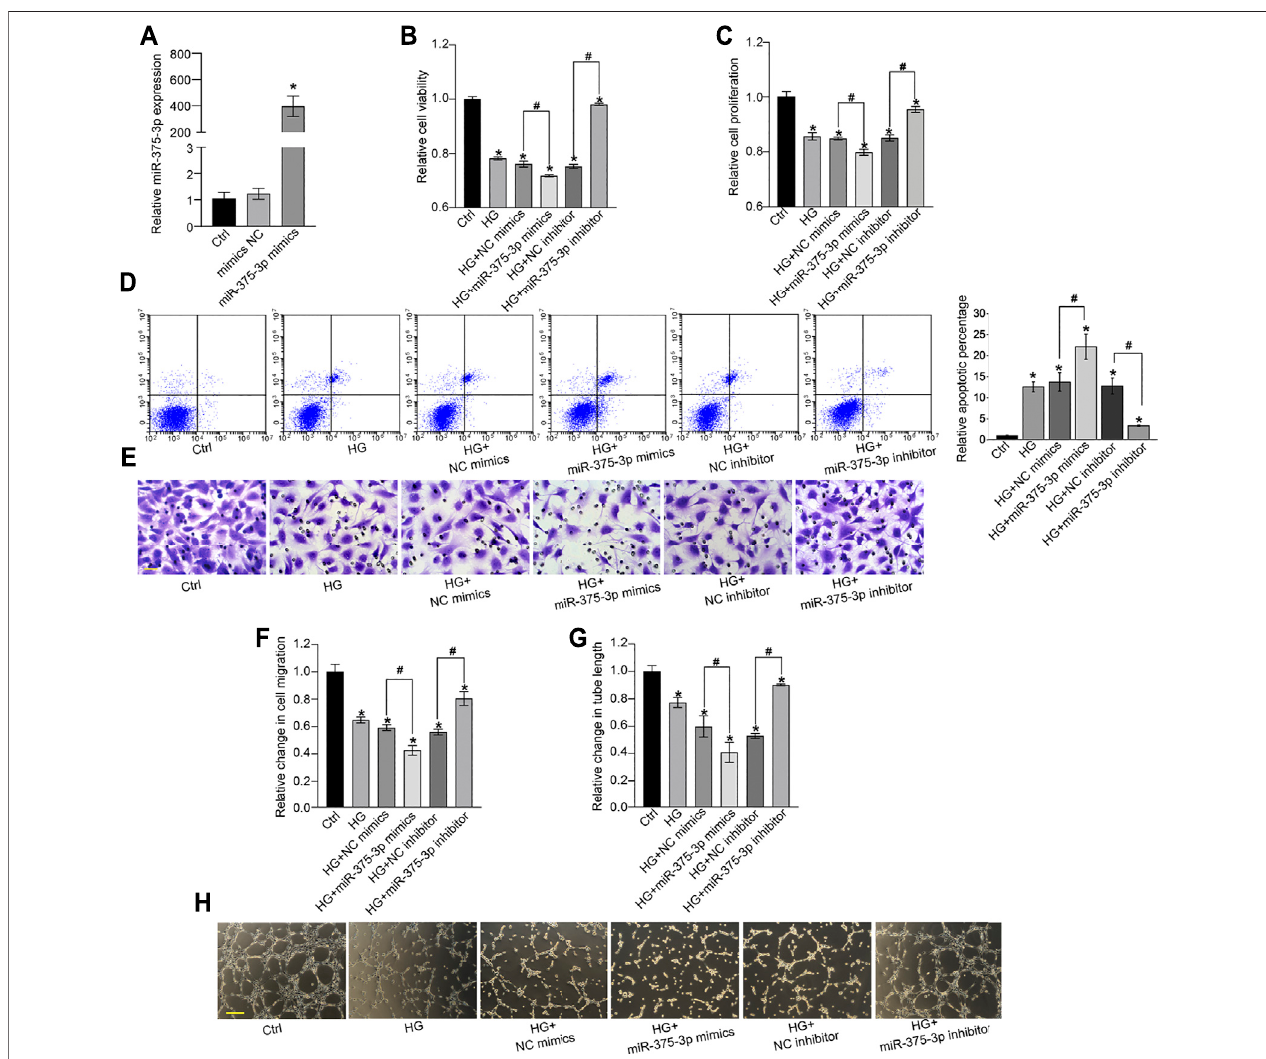
FIGURE 4 | miR-375 – 3p regulates EPC function in vitro . (A) EPCs were transfected with negative control (NC) mimics, miR-375 – 3p mimics, or left untreated (Ctrl) for24 h.TheexpressionofmiR-375 – 3pwasdetectedbyquantitativereversetranscription-polymerasechainreaction(qRT-PCR) (A) . (B – H) EPCsweretransfectedwith NC mimics, miR-375 – 3p mimics, NC inhibitor, miR-375 – 3p inhibitor, or left untreated (Ctrl) for 24 h and then treated with or without high glucose (30 mM) for 24 h. The viabilityofEPCswasdeterminedbyMTTassays (B) .TheproliferationabilityofEPCswasdeterminedbyCCK-8assays (C) .Flowcytometryassaysandquantitative analysis were conducted to detect cell apoptosis (D) . Cell migration and quantitative analysis was conducted using Transwell assays [ (E,F) , scale bar: 20 μ m]. Tube formation assays and quantitative analysis were conducted to detect the tube-formation activity of EPCs [ (G,H) , scale bar: 50 μ m]. * p < 0.05 versus Ctrl group; Pound sign ( # ) indicates signi fi cant differences between the marked groups. All experiment was repeated three times.